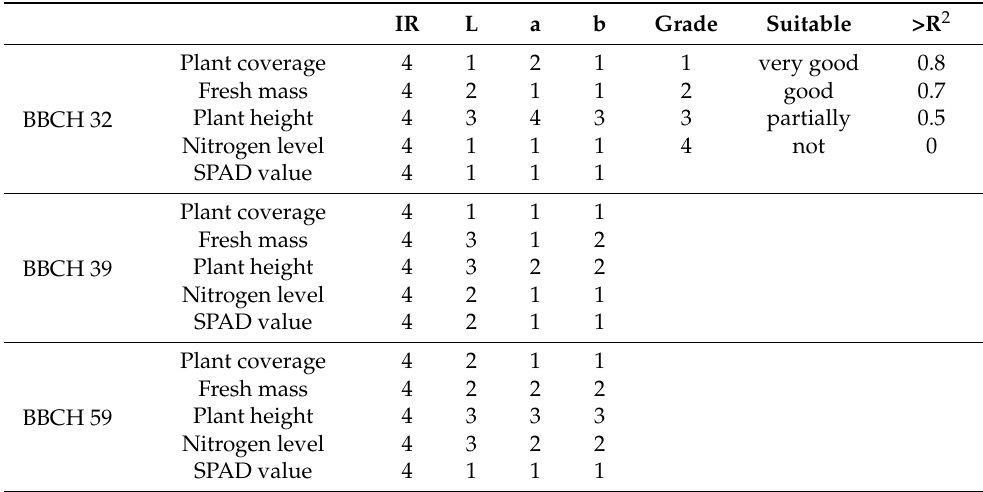
Table 2. Evaluation matrix of the reflection channels concerning their specific sensitivity for the recorded agronomic parameters and SPAD